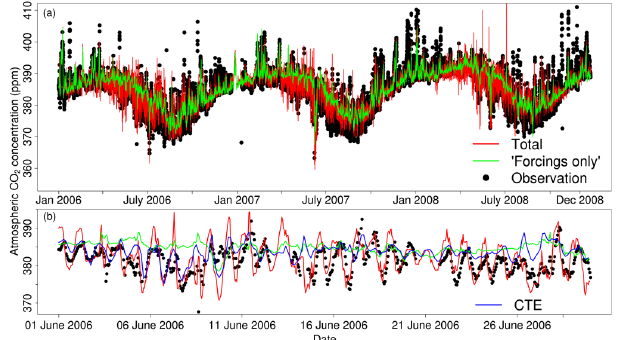
Fig. 2. Time series comparison between hourly observations of at- mospheric CO 2 concentrations made at TTA and WRF-SPA simu- lated total atmospheric CO 2 and “forcings only” CO 2 . Atmospheric CO 2 concentrations at 3-hourly time step from CTE-CT are also in- cluded in (b) . (a) Shows that the simulated CO 2 time series (2006- 2008) is mostly driven by forcings originating outside of the model domain, as indicated by “forcings only” CO 2 . (b) Shows an hourly (3 hourly for CTE-CT) time series for June 2006, highlighting that diurnal variation in simulated CO 2 is due to exchange with the biosphere within the simulated domain, as total atmospheric CO 2 captures this variation. WRF-SPA modelled total atmospheric CO 2 contains all model forcings and exchange with the simulated bio- sphere, while “forcings only” CO 2 does not include biospheric ex- change (i.e. total–biospheric fluxes